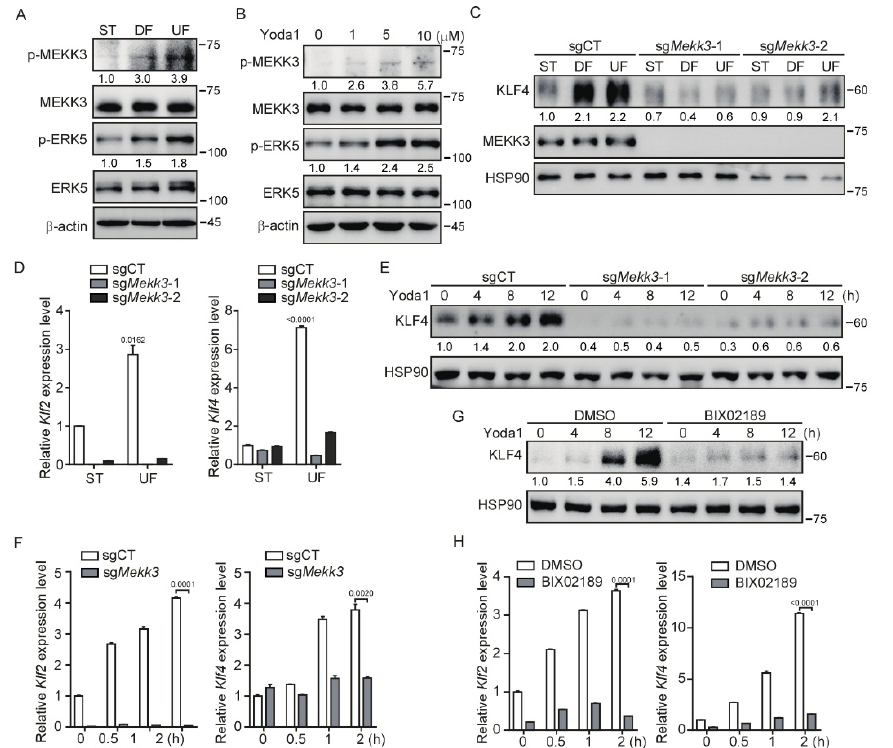
Figure 3. MEKK3 deletion in endothelial cells restrains PIEZO1-induced KLF2/4 expression. ( A ) MBMECs were exposed to differential shear stress for 5 days, and cell lysates were probed with the indicated antibodies. ( B ) MBMECs were treated with Yoda1 with the indicated concentration for 2 h, and cell lysates were probed with the indicated antibodies. ( C , D ) Control and Mekk3 -dificient MBMECs were exposed to differential shear stress for 5 days. KLF4 and MEKK3 proteins were monitored by western blotting ( C ), and mRNA levels of Klf2 and Klf4 were measured by quantitative RT-PCR ( D ). ( E , F ) Control and Mekk3 -dificient MBMECs were treated with Yoda1 (5 μM) for the indicated time, and KLF4 proteins ( E ) and mRNA levels of Klf2 and Klf4 ( F ) were monitored by western blotting and quantitative RT-PCR respectively. ( G , H ) MBMECs were pretreated with MEK5 inhibitor (BIX02189, 10 μM) for 12 h and then treated with Yoda1 (5 μM) for the indicated time. KLF4 proteins ( G ) and mRNA levels of Klf2 and Klf4 ( H ) were monitored by western blotting and quantitative RT-PCR, respectively. Data are representative of three independent experiments and are presented as mean ± SEM of three technical replicates by an unpaired Student’s t -test ( D , F , H ). The immunoblot was measured using ImageJ to determine the relative intensities of the indicated bands, which were normalized using the internal loading control proteins. The relative intensities are shown as numbers. ST: static culture; UF: unidirectional laminar flow.